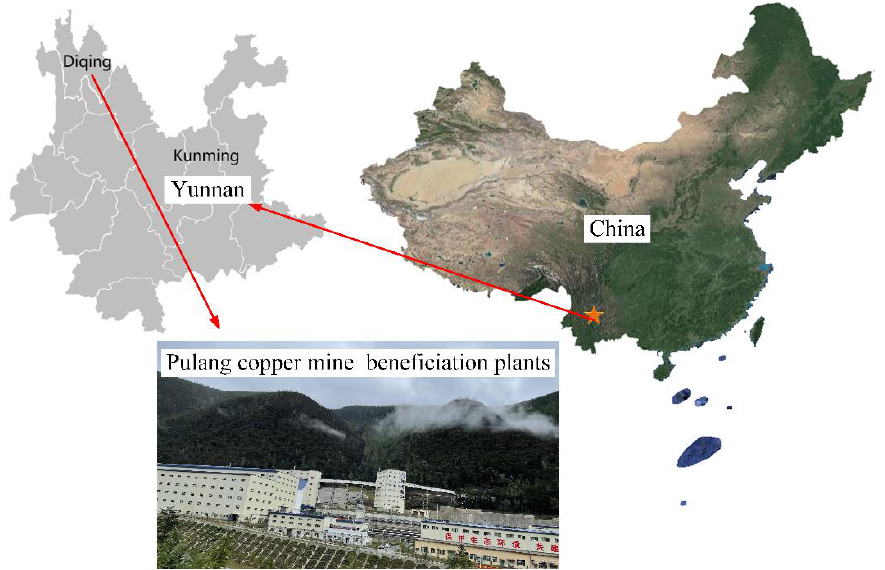
Figure 1. Location of the Pulang copper